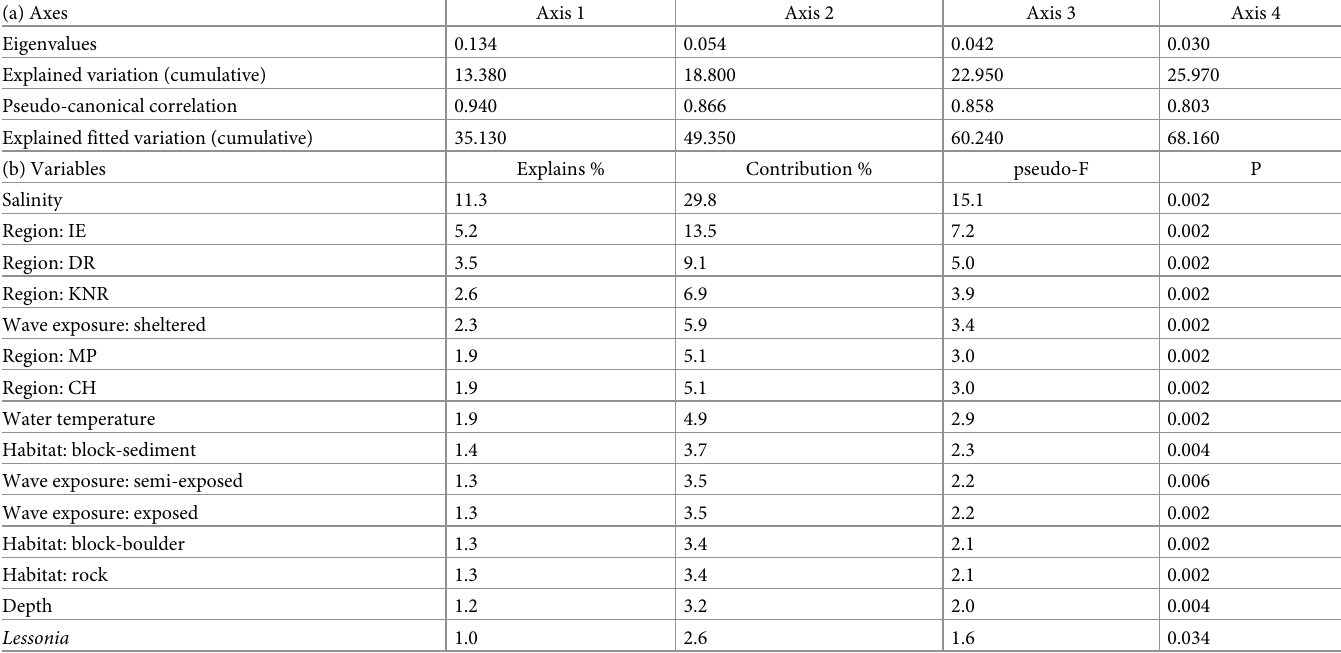
Table 3. (a) Results of redundancy analysis (RDA) on ln(x+1) transformed benthic taxa abundance (num. m -2 ) by transect. (b) Conditional effects of Monte-Carlo per- mutation results on the